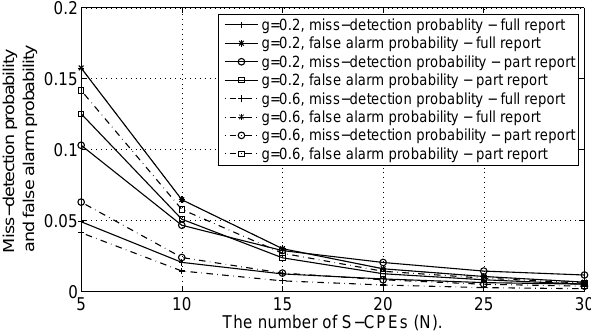
Figure 5. Normalized saved energy/bandwidth as function of the instantaneous SNR threshold. Rayleigh fading channel with ¯ γ of 10 dB, N = 10 .